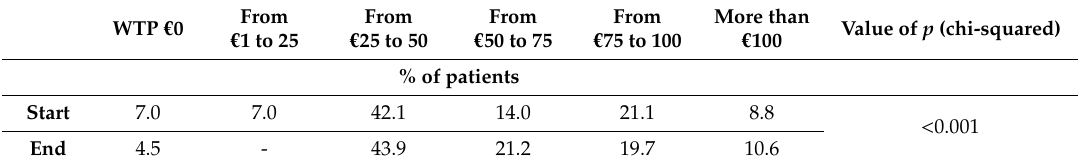
Table 6. Willingness to pay (WTP) for each ostomy-specialized advanced practice nurse (APN-O) follow-up consultation and consultation for complications control in patients with